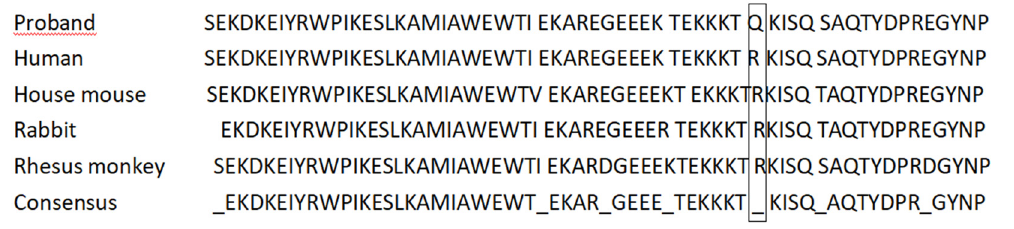
Figure 3: Alignment of RyR1 protein sequences. The alignment shows the comparison of the RyR1 protein sequence of the proband with that of other